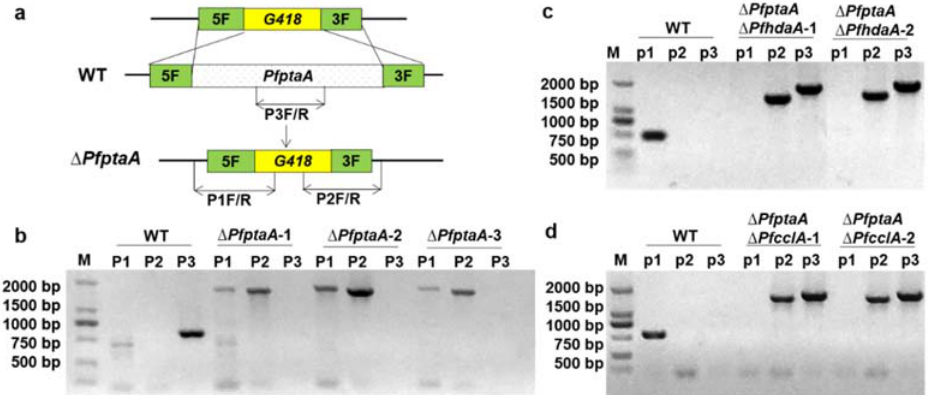
Figure 1. Generation of gene deletion strains. ( a ) Schematic illustration for disruption of PfptaA gene in P. fici ; ( b ) PCR verification for PfptaA gene deletion in P. fici wild ‐ type strain. The primer pairs of P1F/R, P2F/R, P3F/R, were designed for screening and the products should be 850, 1850, 1780 bp, respectively; ( c ) PCR verification for PfhdaA gene deletion in Δ PfptaA host; ( d ) PCR verification for PfcclA gene deletion in Δ PfptaA host.